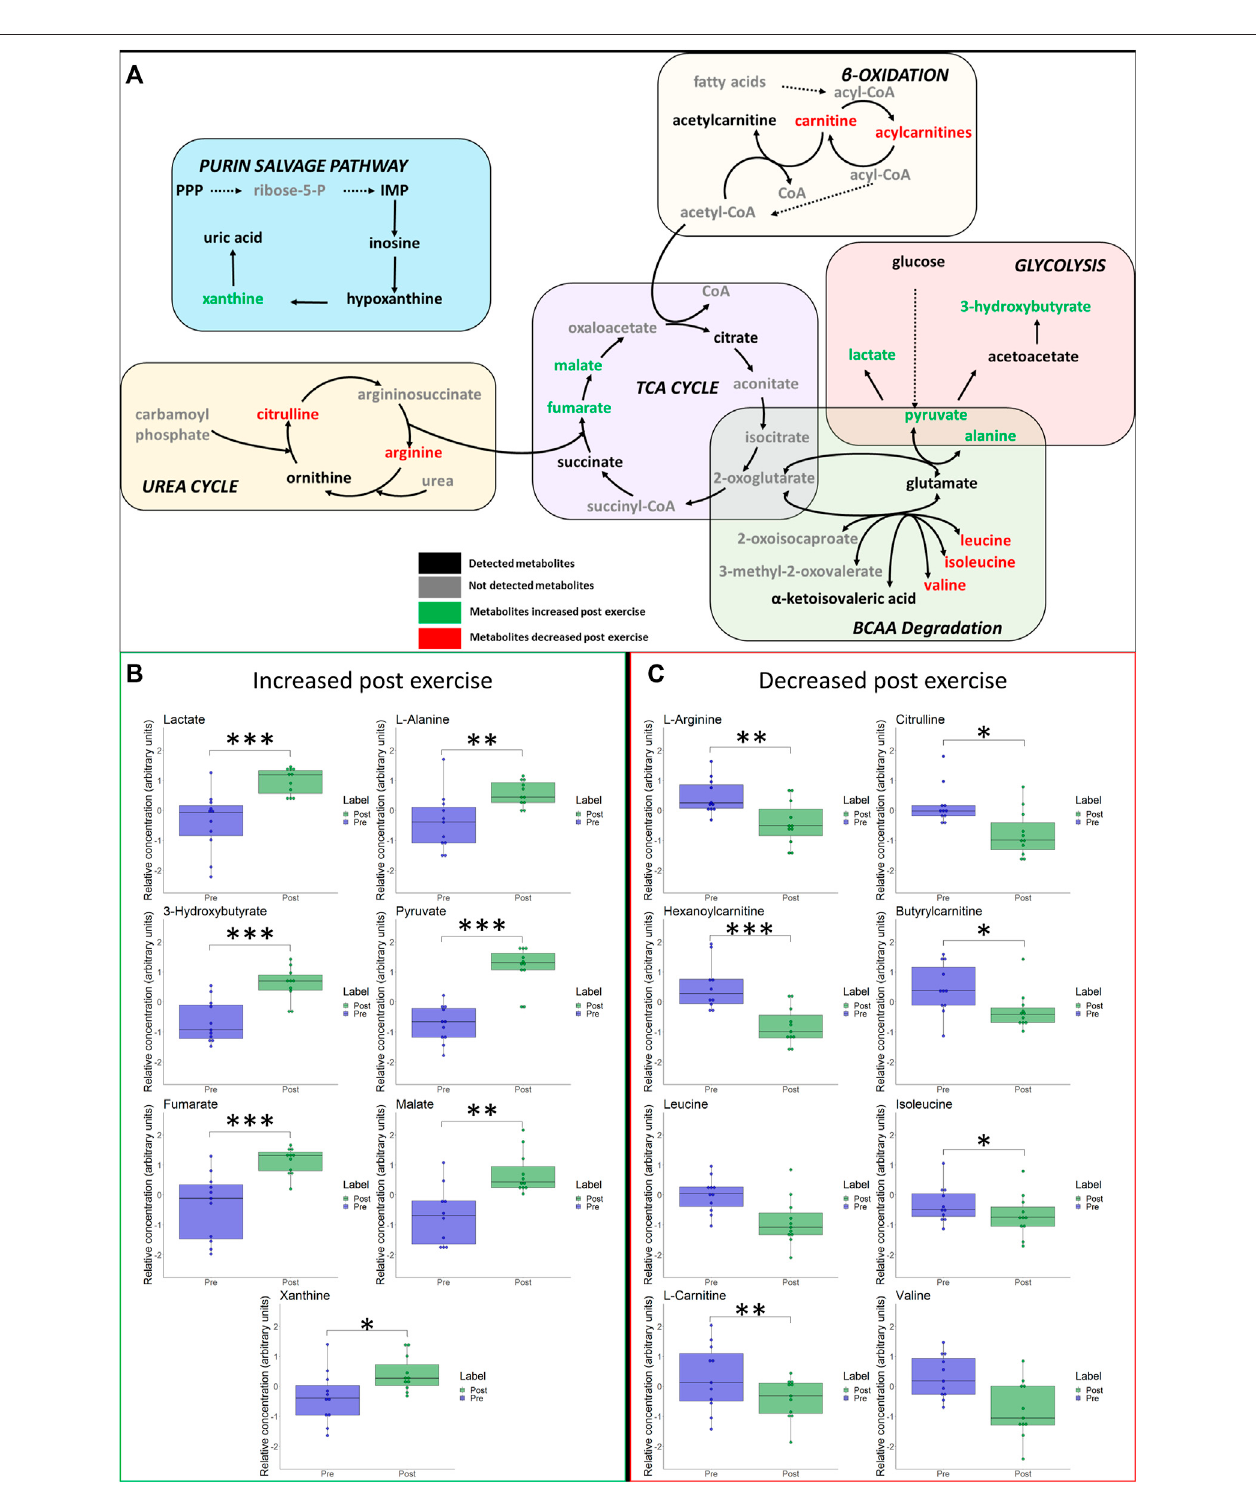
FIGURE 5 | (A) Schematic overview of most important metabolic pathways. Changes of selected metabolites related to glycolysis, betta-oxidation, TCA-cycle, urea cycle and branched-chain amino acids (BCAA) immediately after hypoxic exercise are shown. Metabolites coloured as green represent metabolites that were upregulated immediately after exercise. Metabolites marked as red represent metabolites that were downregulated immediately after exercise. Metabolites marked as black represent detected metabolites whereas grey indicates non-detected metabolites. * p ≤ 0.05, ** p ≤ 0.01, *** p ≤ 0.001 for signi fi cant increases (B) or decreases (C) in associated metabolites post exercise.